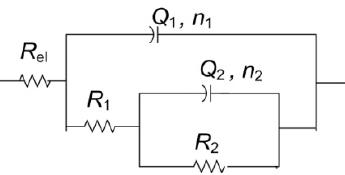
Figure 10. Electrical equivalent circuit used for analysis of EIS data in Figure 9. Table 5. EIS parameters obtained by fitting impedance data in Figure 9.